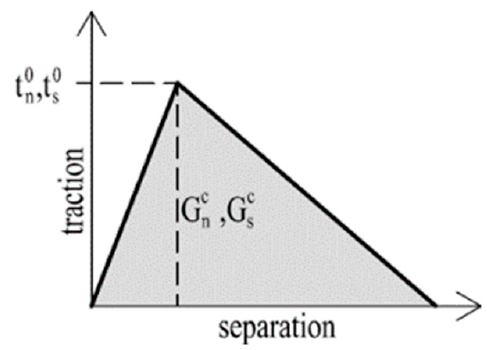
Figure 14. Triangular shape for fracture energy.